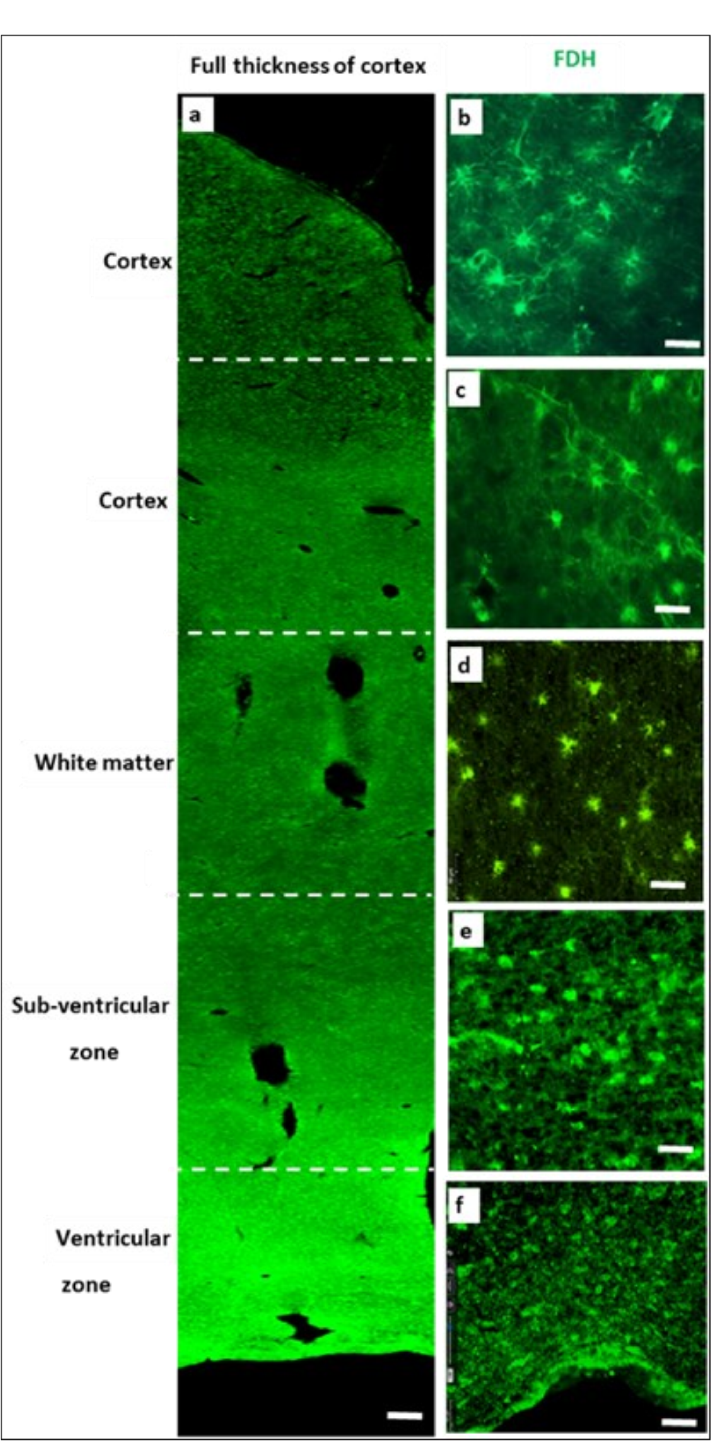
Figure 2. Immunofluorescence staining of Braak 0-II brain sections for FDH (green). Left panel ( a ) shows the entire section of cortex shown at low power (5 × ; scale bar: 2 mm) to orientate the different regions of brain shown in the right panels ( b – f ) at 200 × , scale bar: 50 µ m. ( b ) Cortex near the pia mater, ( c ) Mid cortex region, ( d ) White matter region, ( e ) sub-ventricle zone, ( f ) ventricular zone. The image is representative of n = 3